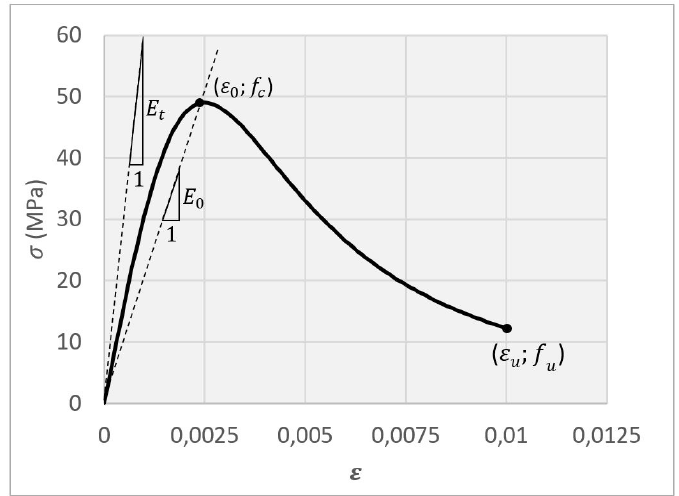
Figure 4. Stress versus strain curve to uniaxial compression adopted for the model. (From the author)